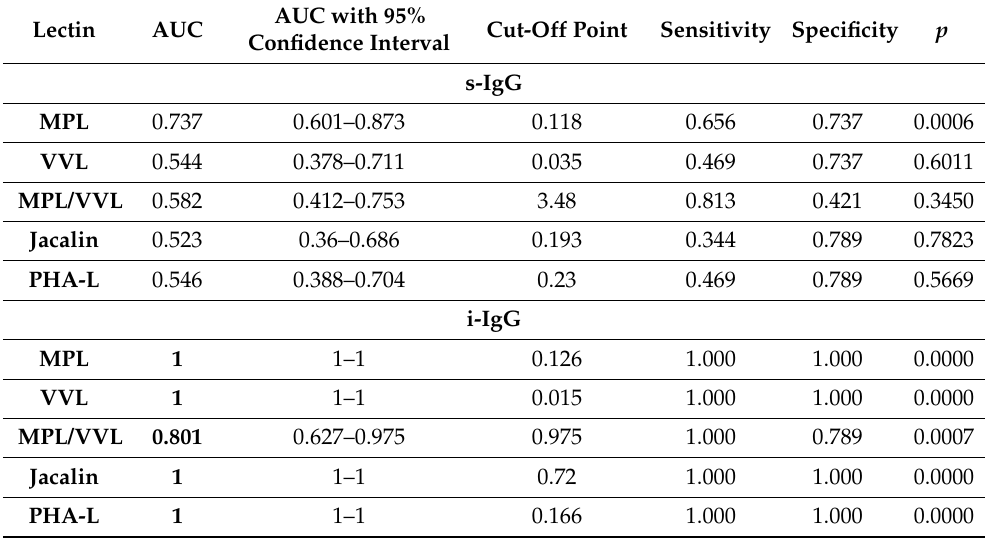
Table 5. ROC curve analysis of s-IgG and i-IgG glycans’ relative reactivities with specific lectins for non-endometriosis and healthy subjects. AUC with 95% Cut-Off Point Sensitivity Specificity p Lectin AUC Confidence Interval s-IgG MPL 0.737 0.601–0.873 0.118